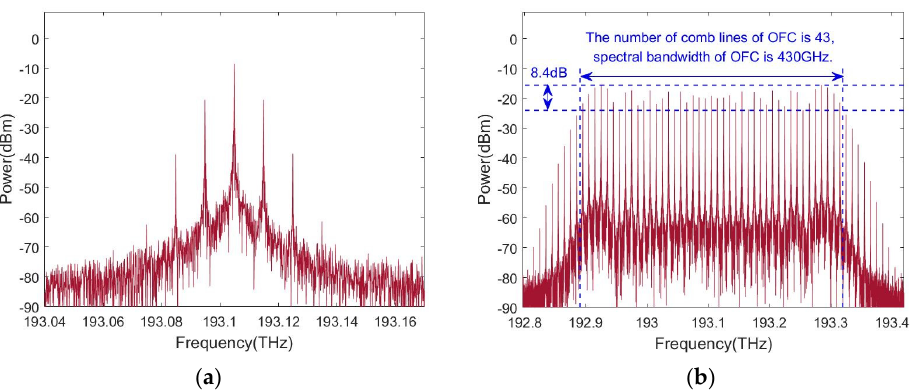
Figure 2. The optical spectrum of OFC output from the SOA ( a ) when the FWM effect is ignored and ( b ) when the FWM effect is considered. ( b ) when the FWM effect is